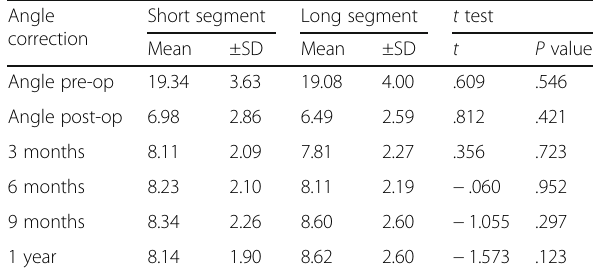
Table 2 Comparison between short-segment fixation and long-